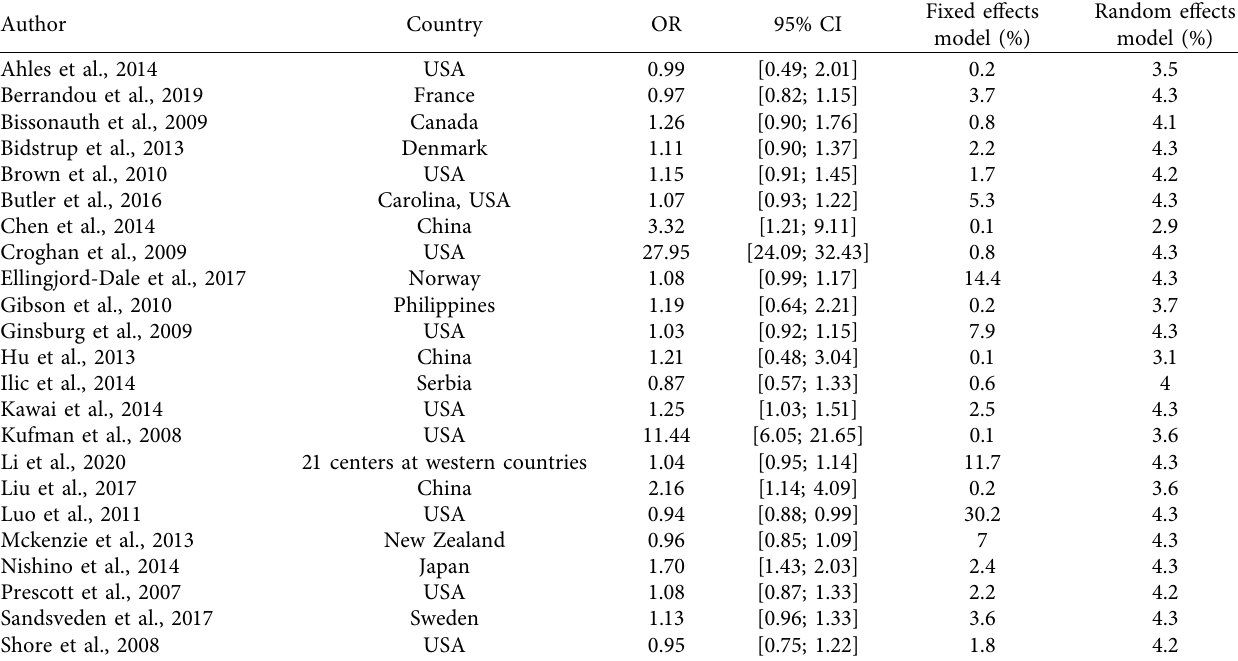
Table 3: Summary of the random efects and fxed efects models for